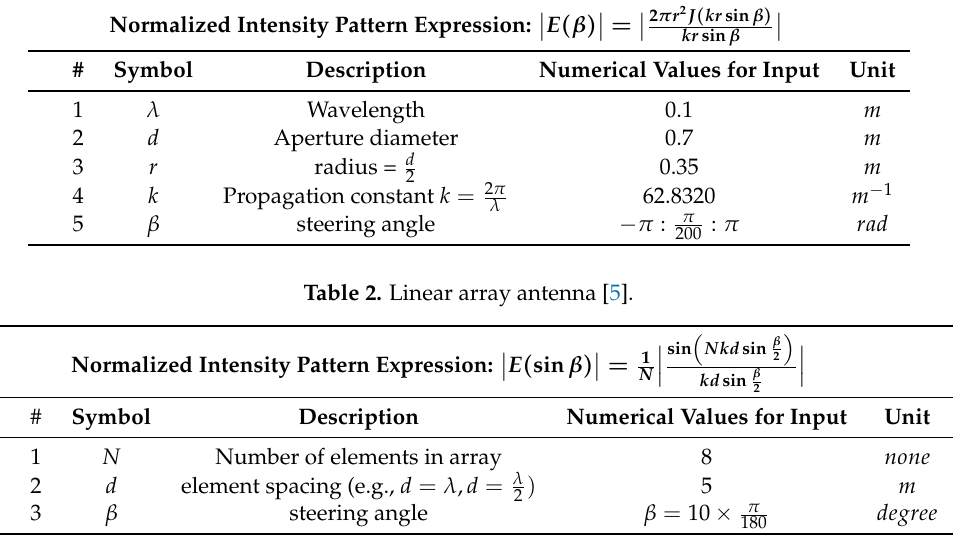
Table 1. Circular dish antenna [5].